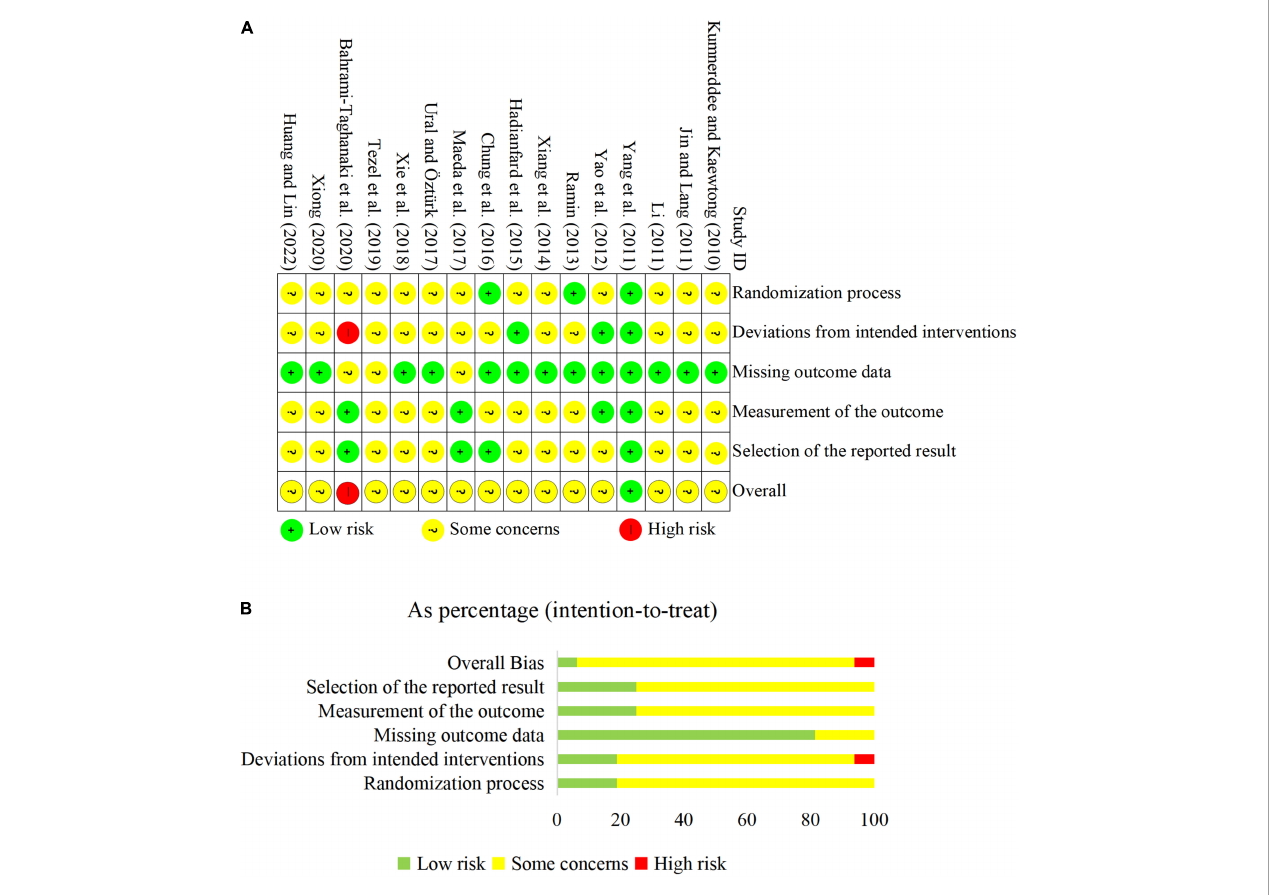
FIGURE2 The results of risk of bias assessment. (A) Risk of bias of individual study; (B) overall risk of